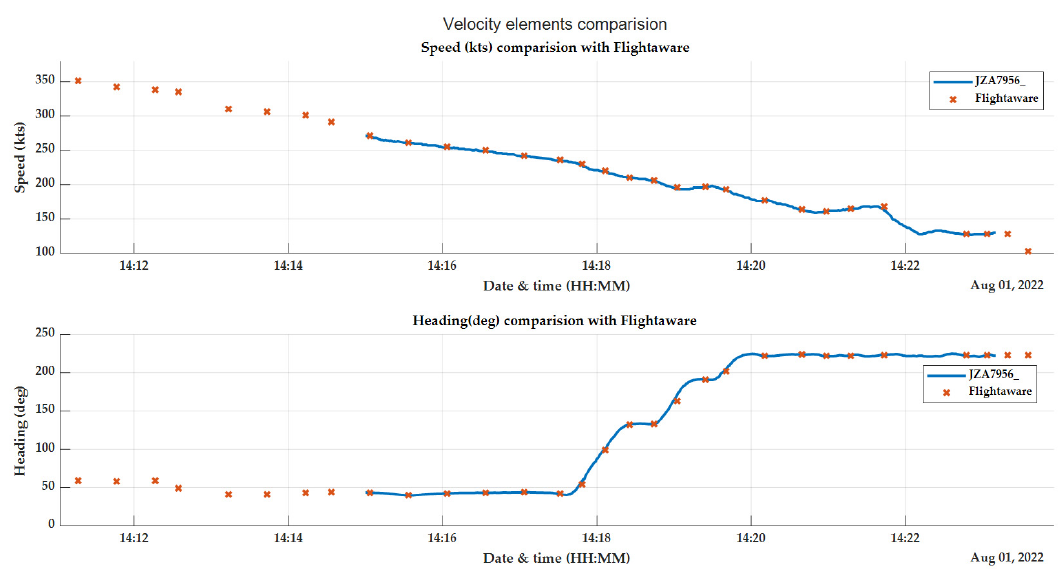
Figure 18. Speed and heading comparison with FlightAware data.